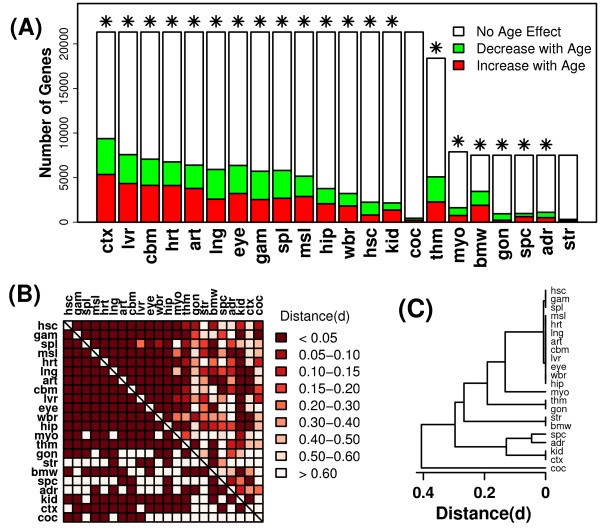
Differential expression patterns associated with aging. Differential expression signatures associated with aging in each tissue were generated based upon integration of results from one or several datasets (see Table 1). (A) The total height of each bar indicates the number of genes for which the effects of aging had been evaluated in at least one experiment (maximum of 21,327 genes). Colored sub-bars indicate the number of genes significantly up regulated (red) or down regulated (green) by aging within each tissue type (given a comparison-wise type I error rate of 0.05). Asterisk symbols (✴) indicate tissues for which a larger number of significant genes were identified than expected by chance. (B) The grid provides information on the pair-wise overlap between differential expression signatures associated with each tissue. The above-diagonal region is color-coded to reflect the distance between differential expression signatures (d). The value of d ranges from 0 to 1, where low values of d indicate that, between two signatures being compared, there exists an over-abundance of genes significantly regulated by aging in the same direction (see Methods). The region below the diagonal is coded in binary fashion, with dark squares indicating significant overlap between two differential expression signatures (P < 0.05) (see Methods). (C) An average linkage hierarchical cluster analysis was applied to differential expression signatures, where distance between signatures was based upon the measure d that is color-coded in the upper-diagonal region of the grid from part (B).